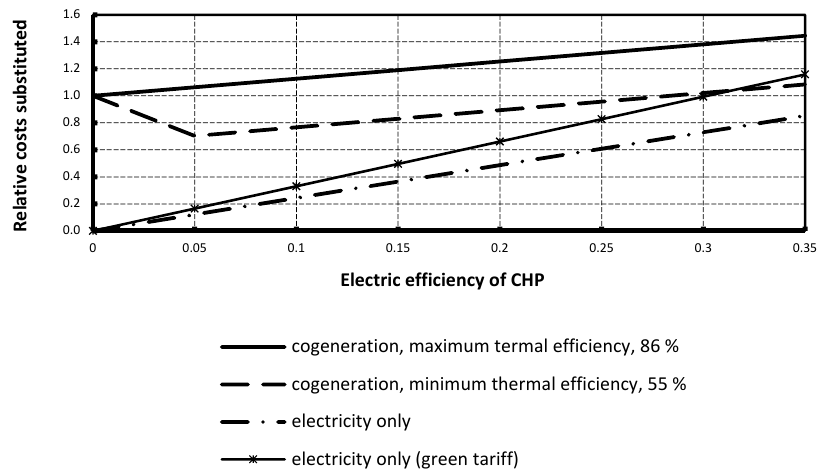
Figure 9. Economic efficiency of CHP (developed by authors).